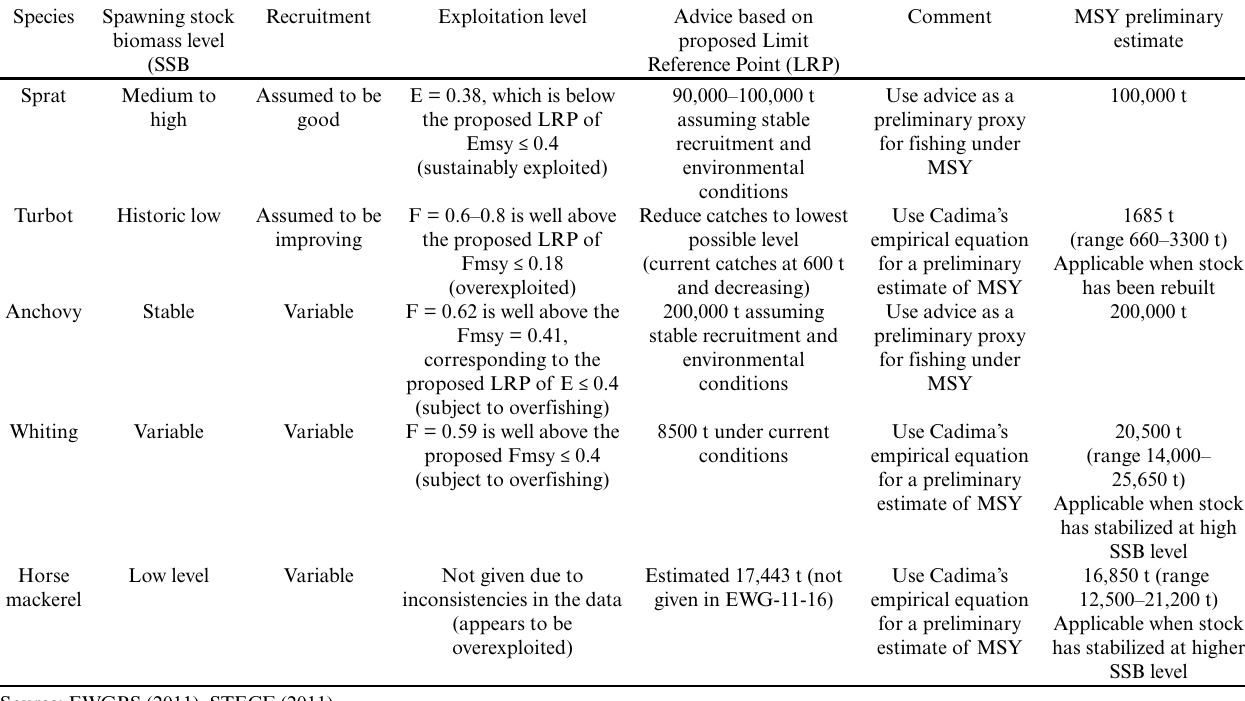
Table 2 . Assessment of Black Sea stocks, including advice given on the exploitation of the stocks and estimates of maximum sustainable yield (MSY) (F = fishing mortality; E = exploitation rate; Emsy = exploitation rate at